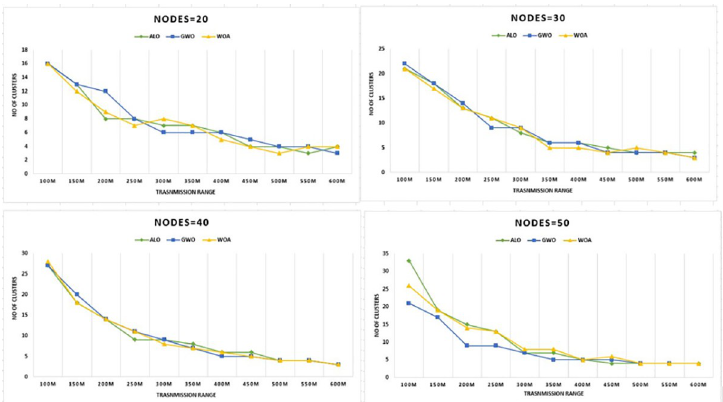
Fig 6. Transmission range versus CHs for nodes 20–50 & grid size 1km x